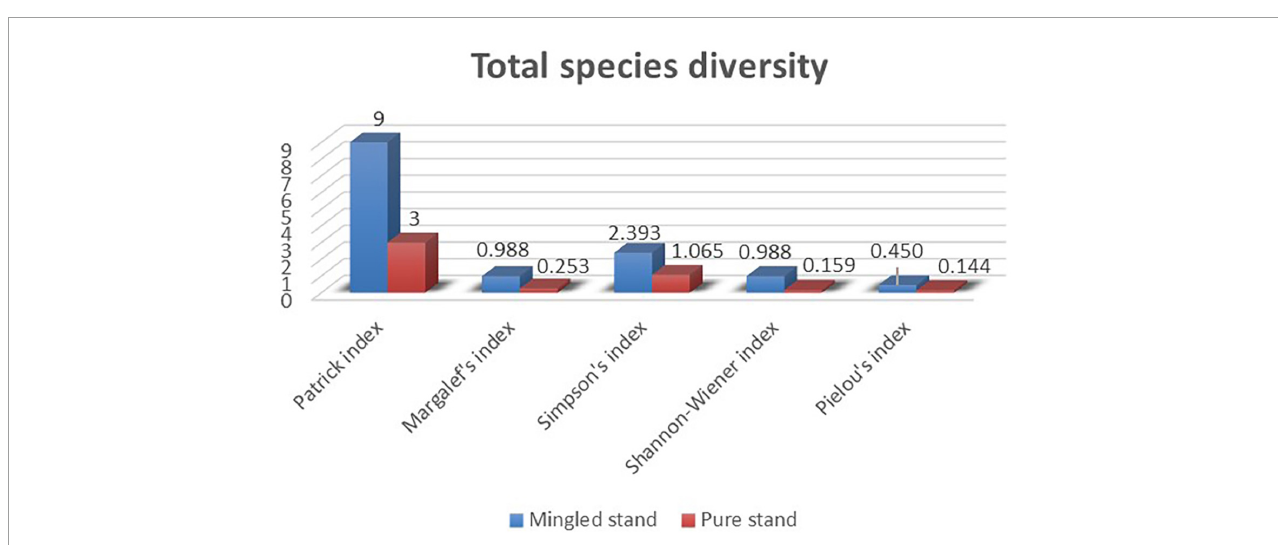
FIGURE8 Total species diversity. The blue is the Mingled stand diversity index, and the red is the pure forest diversity index. It includes Patrick index, Margalef’s index, Simpson’s index, Shannon–Wiener index, Pielou’s index.